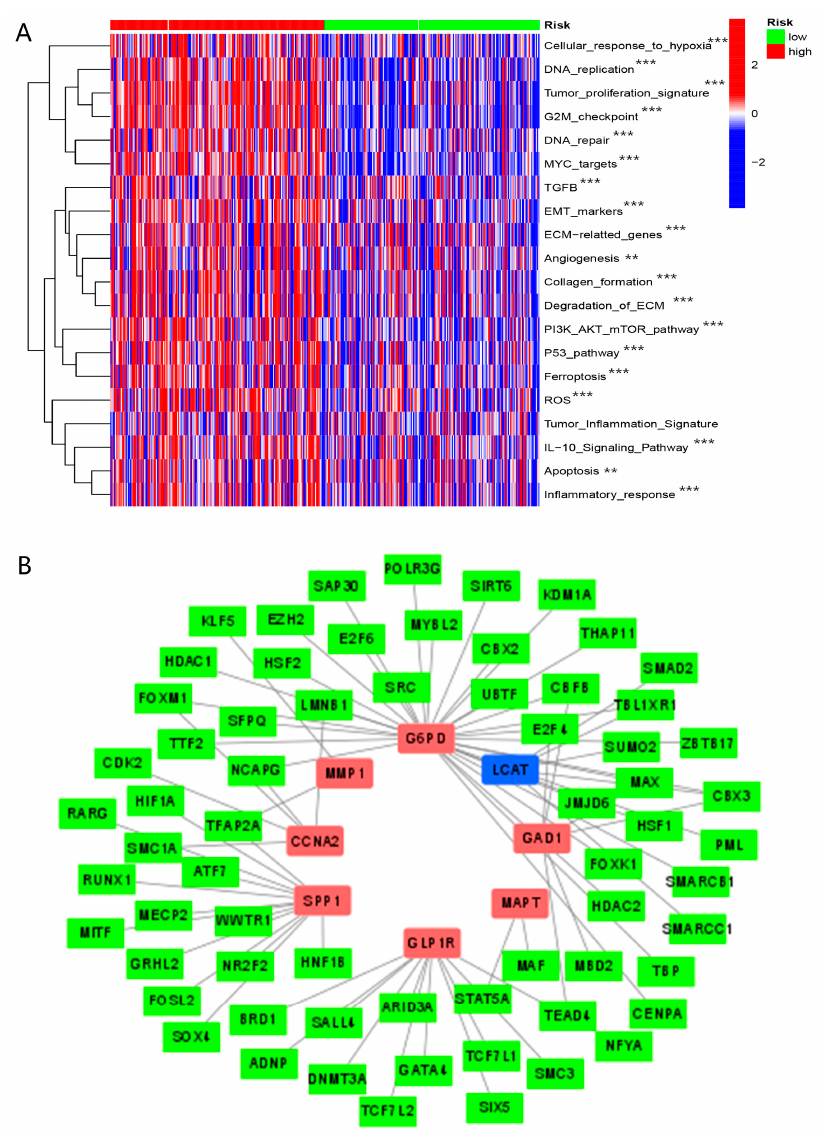
Figure 16. The molecular functions analyses. ( A ) Comparison of enrichment scores of tumor-associated pathways in high- and low-risk groups with the ssGSEA algorithm. ( B ) Network of genes constituting BMGs with specific transcription factors. (“**”, “***” represent p < 0.01, p < 0.001, respec- tively).